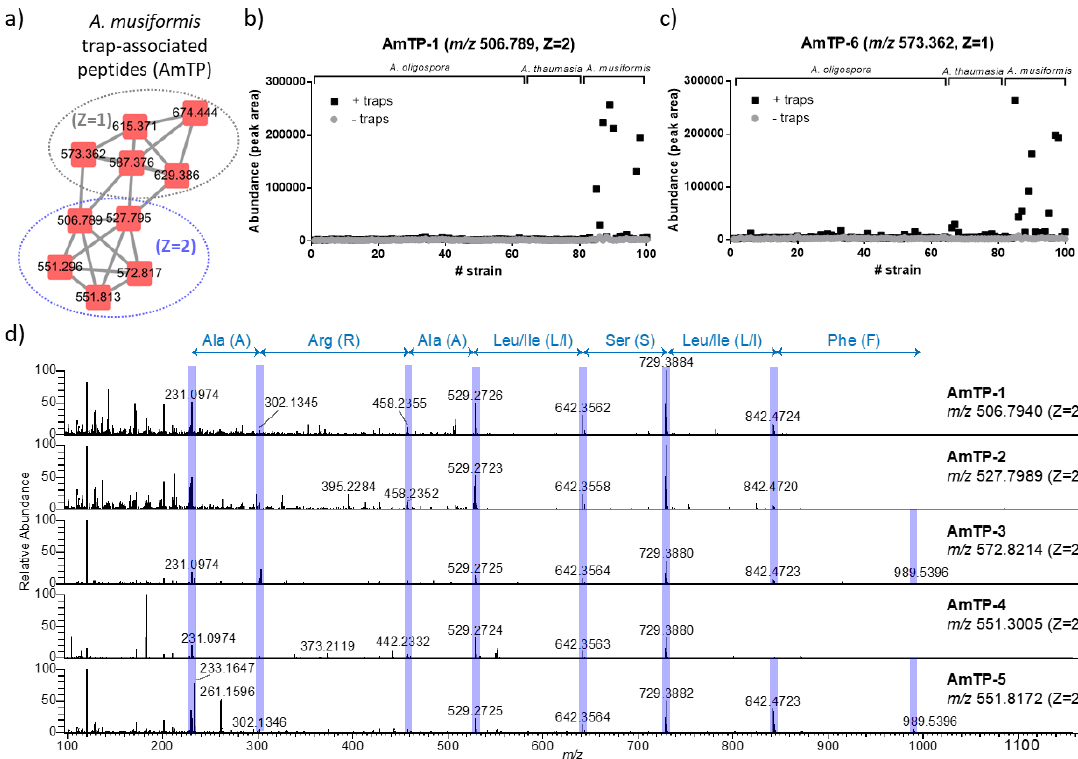
Figure 3. The annotation of Arthrobotrys musiformis trap-associated peptides (AmTPs). ( a ) The molecular cluster of the Arthrobotrys musiformis trap-associated peptides (AmTPs). The parent ion m / z and charge stage (Z) were shown. ( b , c ) The abundance of the AmTPs in each Arthrobotrys strain before and after forming the traps (exemplified by a doubly charged AmTP-1 in ( b ); a singly charged AmTP-6 in ( c )). The peptides were specific to the strains of the species A. musimorfis . Abundance was estimated by the LC–MS peak area. ( d ) Tandem mass spectrometric interrogation of the doubly-charged A. musiformis peptides. The fragments indicating amino acid sequences are highlighted.